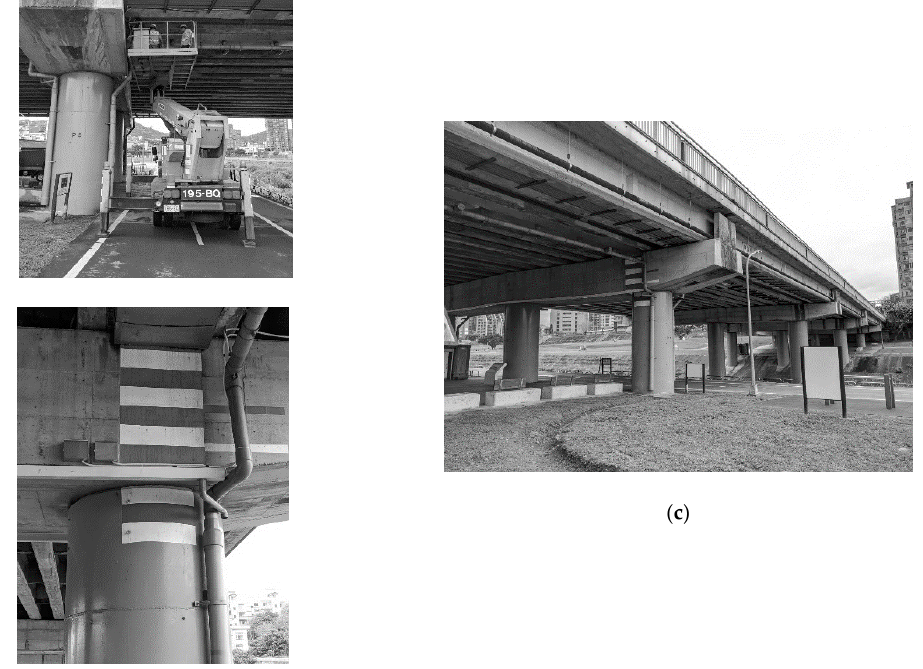
Figure 27. Calculated fundamental frequencies for each set of data. D o m i n a